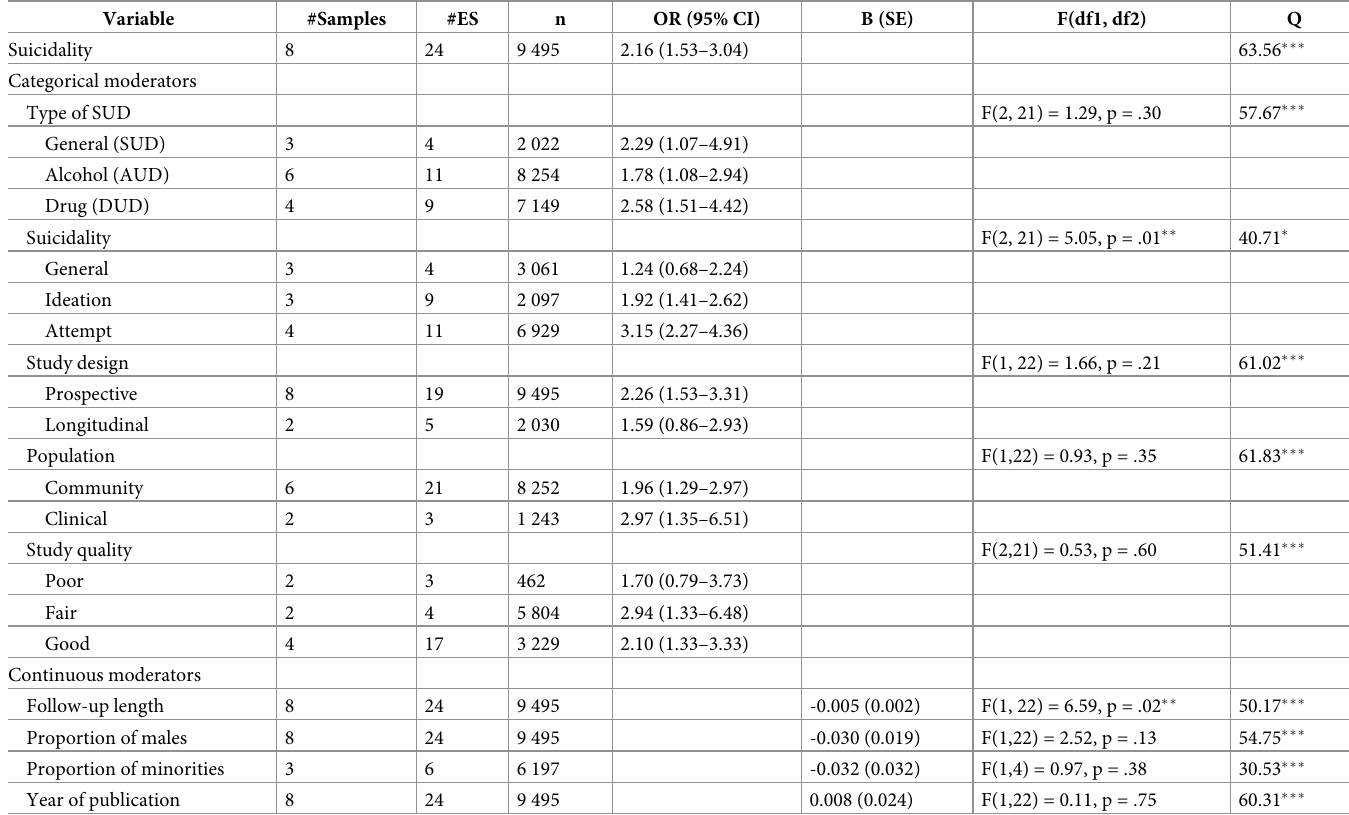
Table 3. Results of the three-level meta-analytic model for the secondary substance use disorder hypothesis